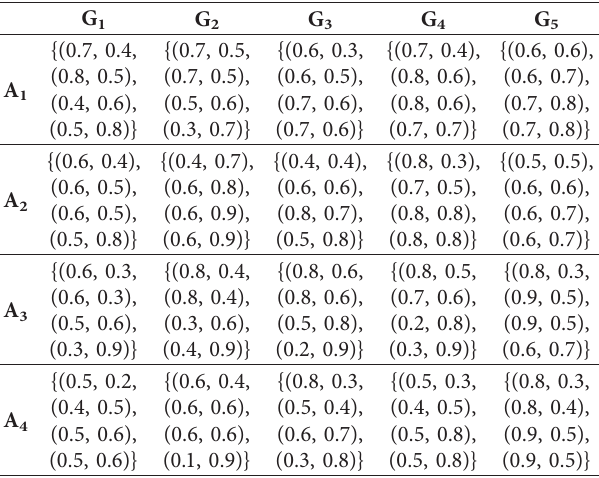
Table 2: Standardized hesitant fuzzy decision matrix with credibility.